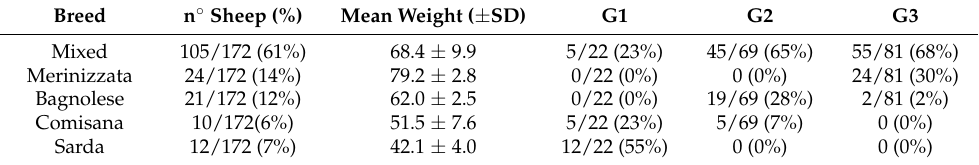
n ◦ : number of sheep; SD: standard deviation; G1: weight ≤ 45 kg; G2: 46 kg ≤ weight ≤ 63 kg; G3: weight ≥ 64 kg; G1 + G2 + G3: total